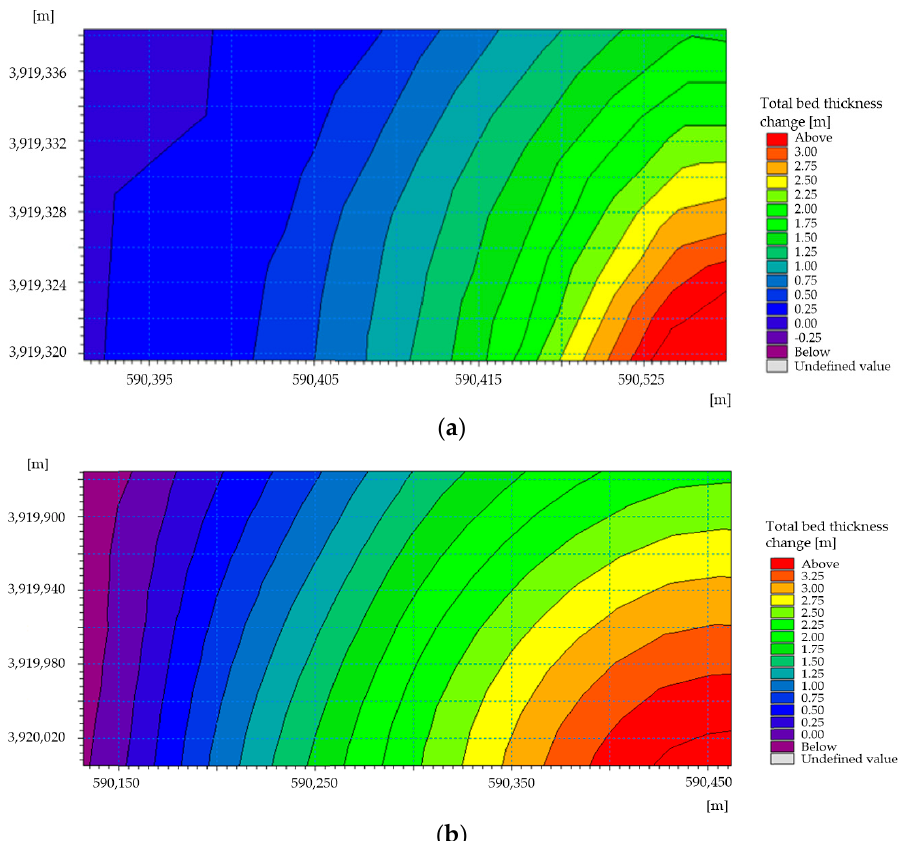
Figure 8. Distribution of local sediment in channel #1 in sedimentation basin. The legend represents silting thickness. ( a ) vertical coordinates is near 3,919,300 m, the coordinate range is (590,395, 3,919,320)~(590,425, 3,919,338). The total bed thickness is negative, which represents the scouring in the sedimentation basin; ( b ) vertical coordinates is near 3,912,000 m, the coordinate range is (590,150, 3,919,900)~(590,450, 3,920,040).